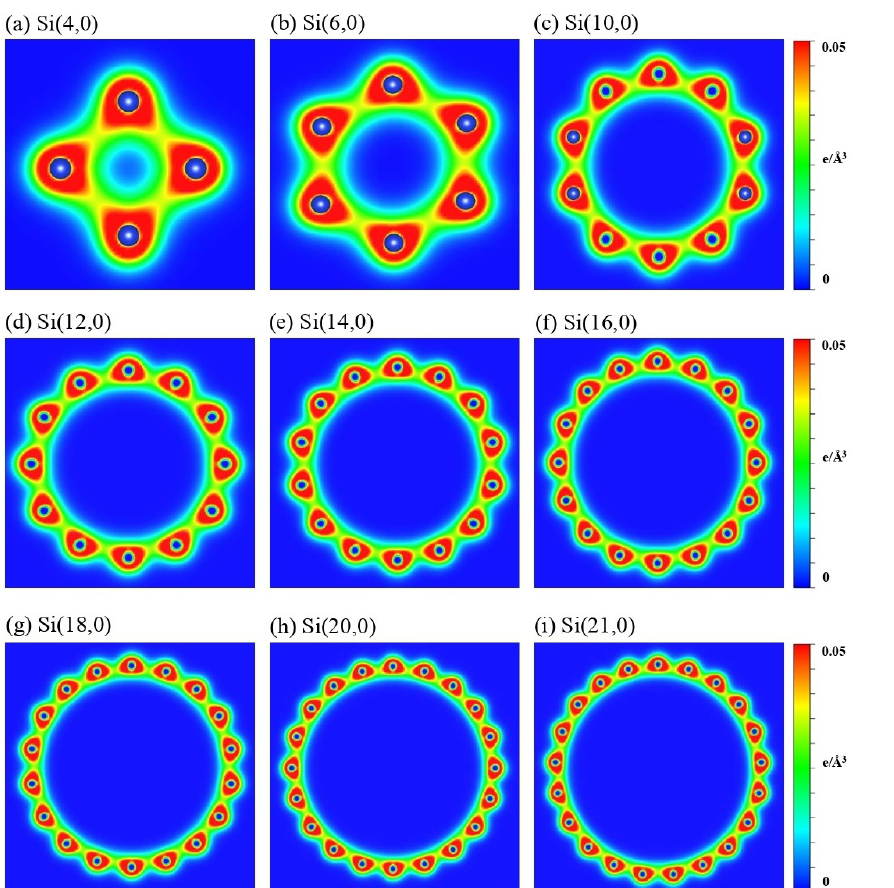
Figure 6. The spatial charge densities on the (x,z)-plane for zSiNTs with different chiral vectors: ( a ) (4,0), ( b ) (6,0), ( c ) (10,0), ( d ) (12,0), ( e ) (14,0), ( f ) (16,0), ( g ) (18,0), ( h ) (20,0), and ( i )